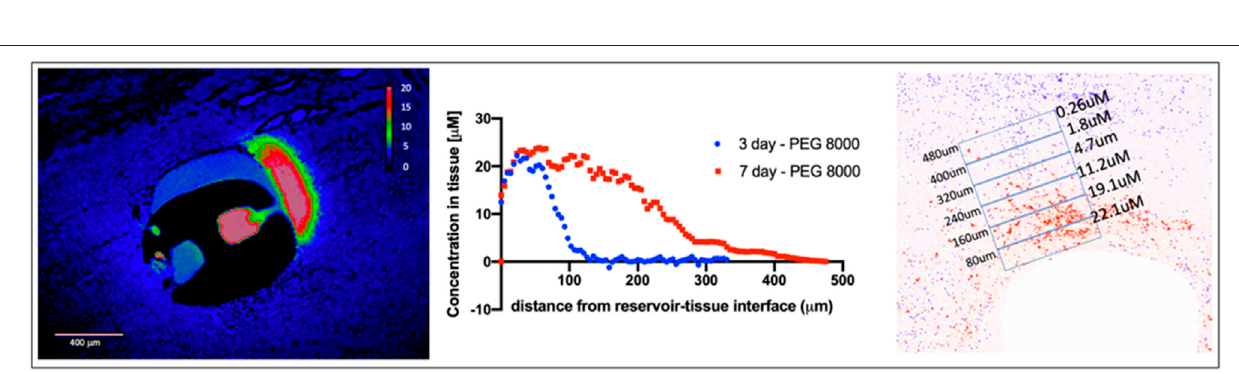
FIGURE 1 | Technical work fl ow of IMD implantation, drug release, processing and analysis in murine brain.